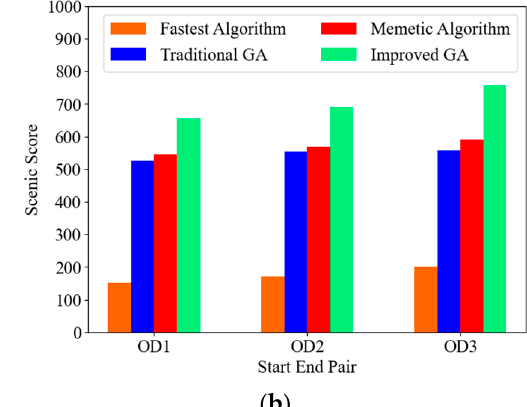
( b ) Figure 9. Comparison of the running time of the algorithm under different start end pairs. ( a ) Xi’an; ( b ) Wuhan. Figure 9 shows the running time of several algorithms for planning different starting and ending routes. The fastest algorithm has the shortest running time, while the tradi- tional GA has the longest. The running time of the improved GA is shorter than that of the MA and the traditional GA. The reason for this is that the improved GA adds a gene replacement operator. The implementation of this operator speeds up algorithm conver- gence to a certain extent. At the same time, the chromosome encoding method of the im- proved GA will not produce too many chromosomes. Overall, on the road network da- tasets of Xi’an and Wuhan, the algorithms show identical performance, but the scenic